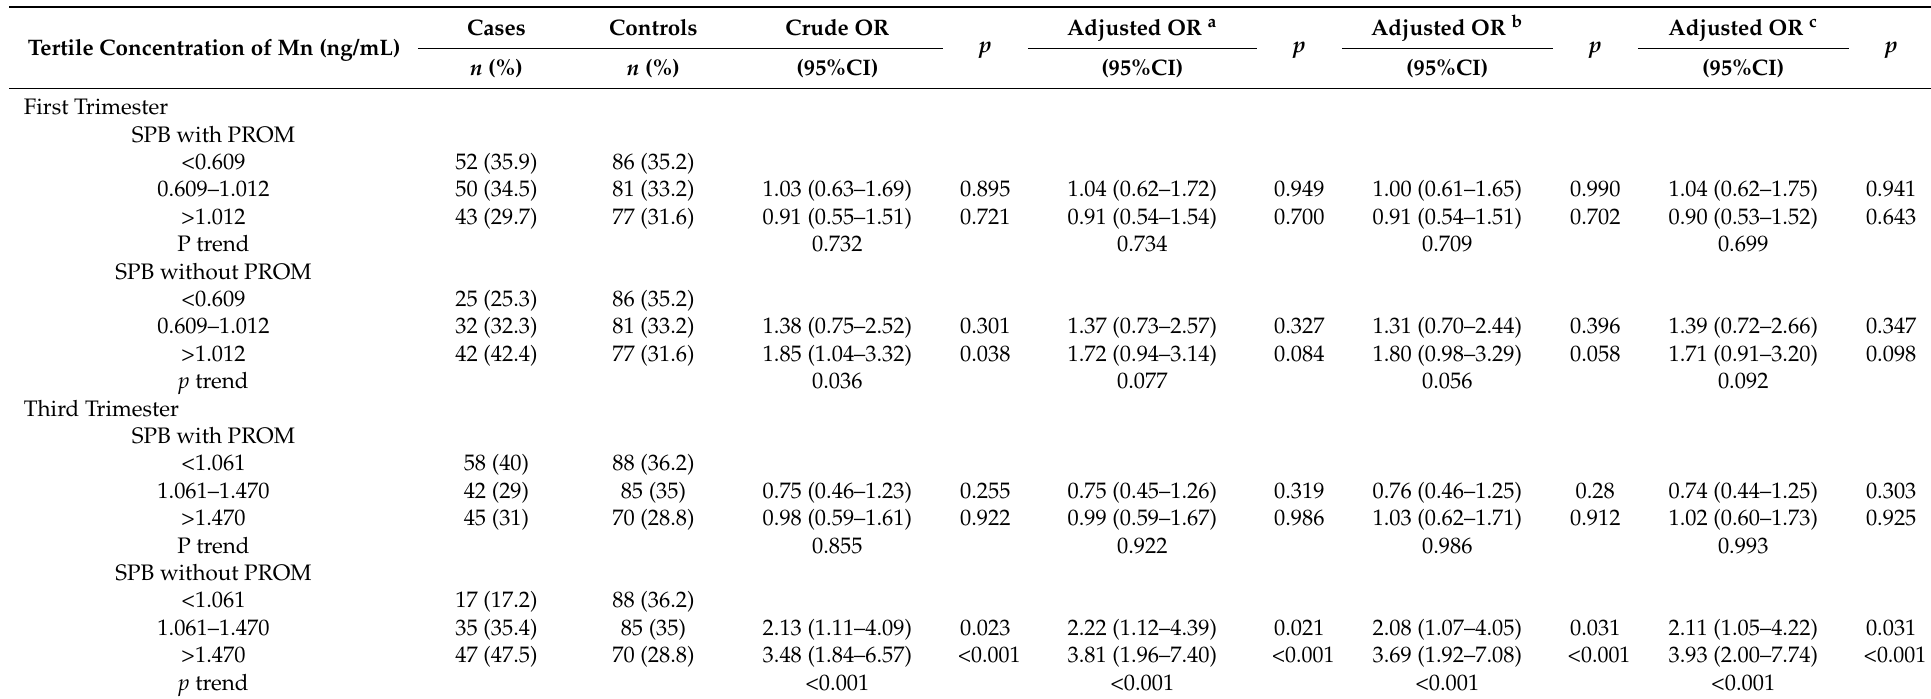
Table 6. Association of maternal plasma Mn levels with SPB stratified by